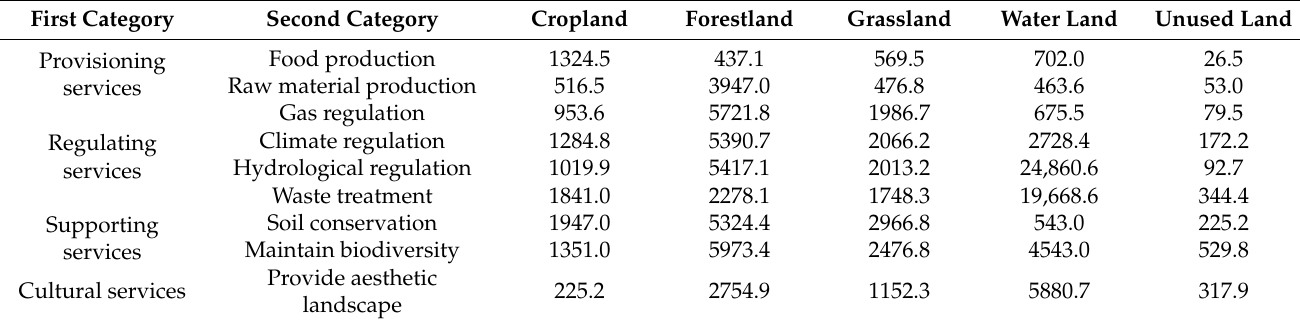
Table 1. Coefficient of the ESV in the Funiu Mountain area in